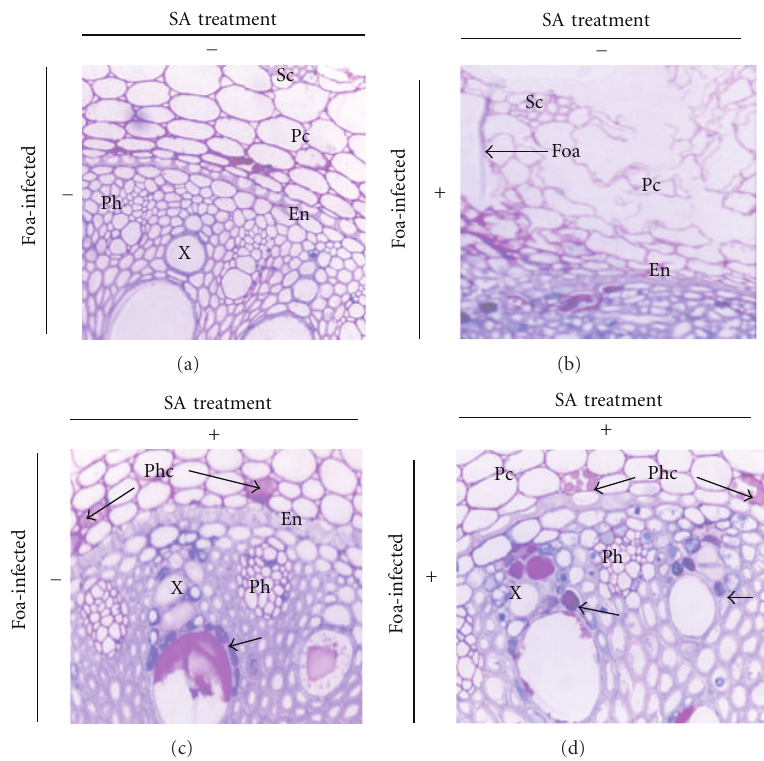
Figure 2: Light micrographs of samples from JHL date palm root tissues inoculated by Fusarium oxysporum f. sp. albedinis (Foa) ( × 40). Proteins were specifically stained in dark blue with NBB and PAS stains starch reserves and cell walls in pink. (a) Control roots (UU); (b) untreated and infected roots (UI); (c) SA-treated roots (TU); (d) SA-treated and Foa-infected roots (TI); note the presence of proteins at the cell layer surrounding the xylem vessels (arrow). X: xylem vessels; Ph: Phloem tubes; Pc: cortical parenchyma; Phc: Phenolic-storing